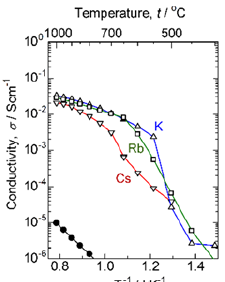
Figure 1. Arrhenius plots of conductivity for Ca 0.9 A 0.1 WO 3.9 . (cid:52) : A = K, (cid:3) : Rb, and (cid:53) : Cs. Conductivity of the pristine CaWO 4 is also plotted by closed circles ( ● ).